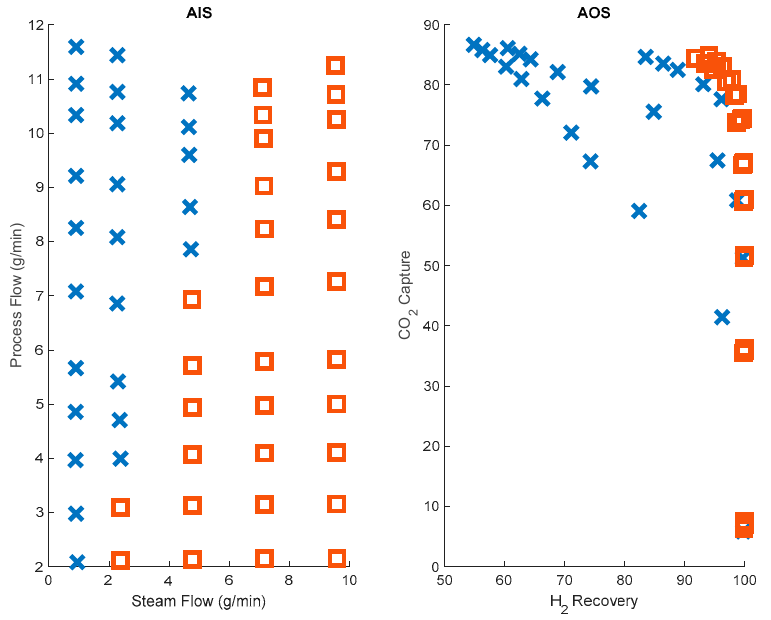
Figure 8. Input-output mapping of the polymer membrane reactor. For ease of understanding, parts of the mapping region (shown using the x and ◻ markings) are marked differently to see how the inputs are mapped to the output space.